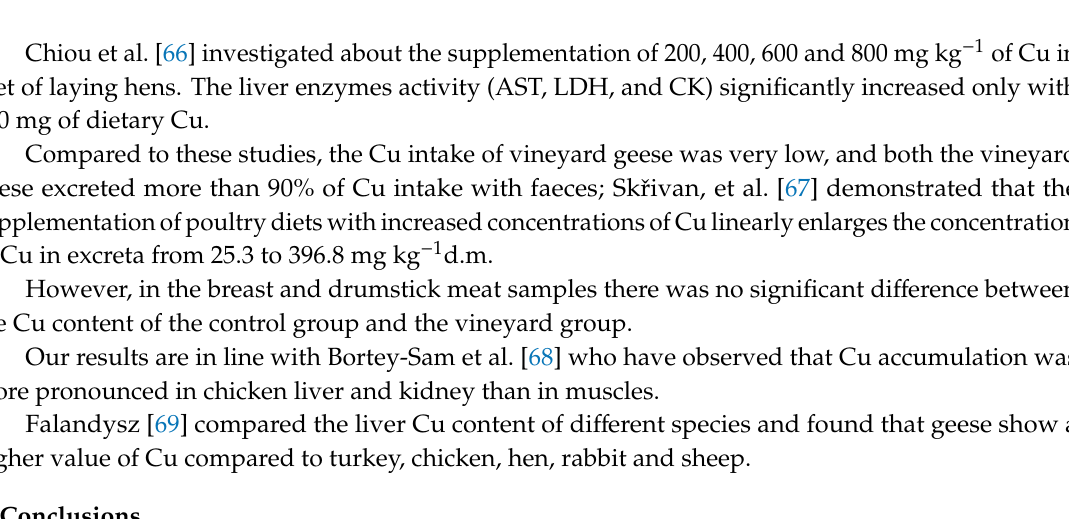
Table 6. Estimated copper intake and copper content in tissues and feces of geese of reared at high and low geese density, and control group. Numbers in parentheses are the standard errors ( n = 2). Traits Unit of Measure LGD HGD Control Estimated Cu intake mg / d 4 (1) 3 (1) 1 (0.9) Liver mg kg − 1 152 (5) b 144 (5) b 95 (3) a Breast meat mg kg − 1 3 (1) 3 (1) 3 (1) Drumstick meat mg kg − 1 1 (1) 1 (0.8) 0.9 (0.5) Feces mg kg − 1 59 (4) b 55 (3) b 23 (3)